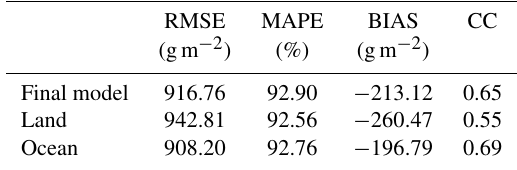
Table 4. Errors in IWP retrieval using different channels. Table 5. Errors in the final selected